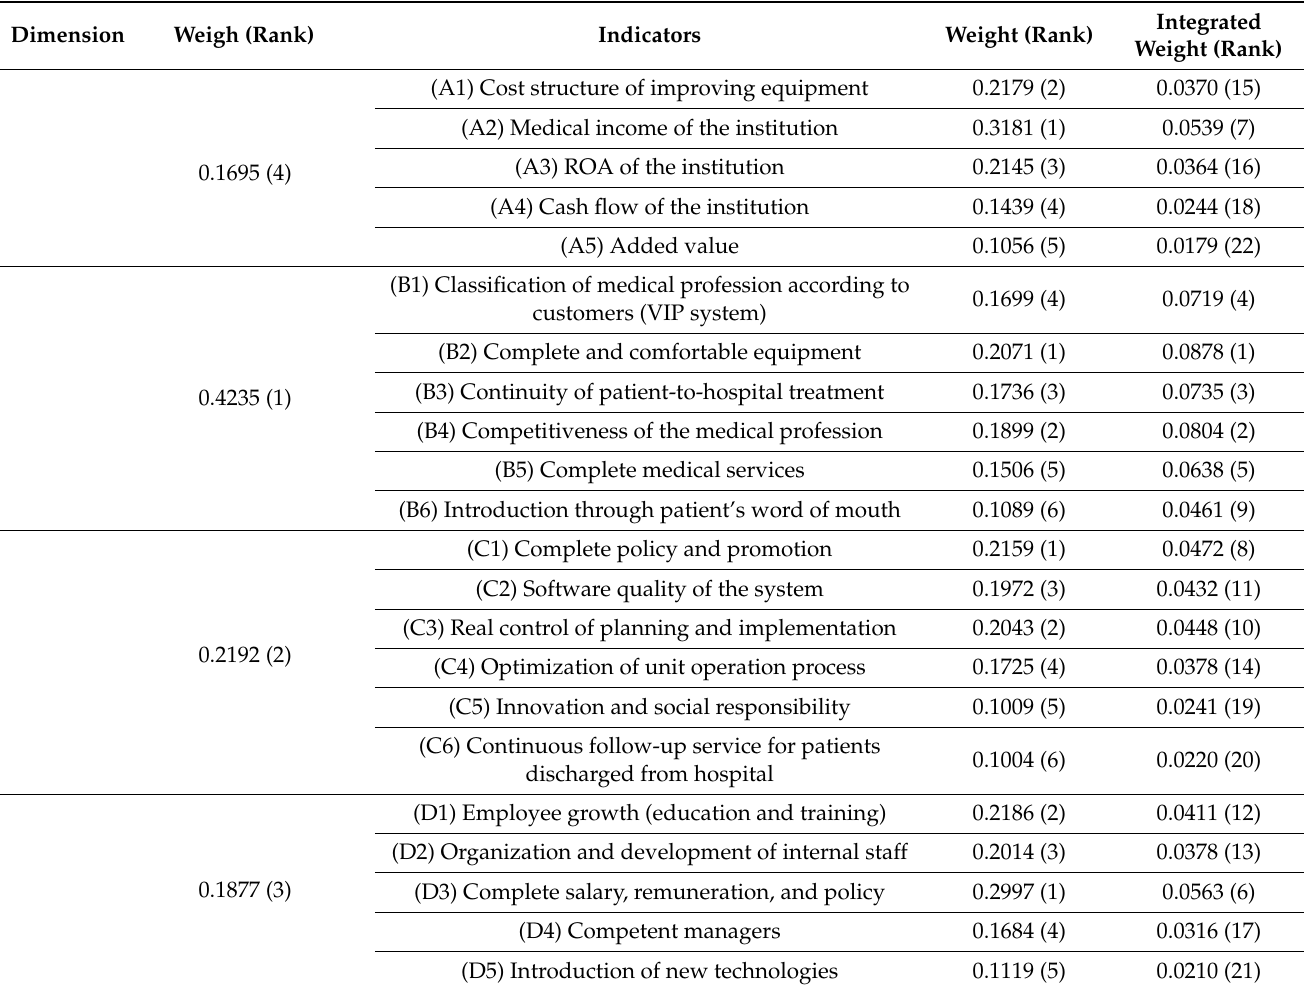
Table 2. AHP results of the service performance